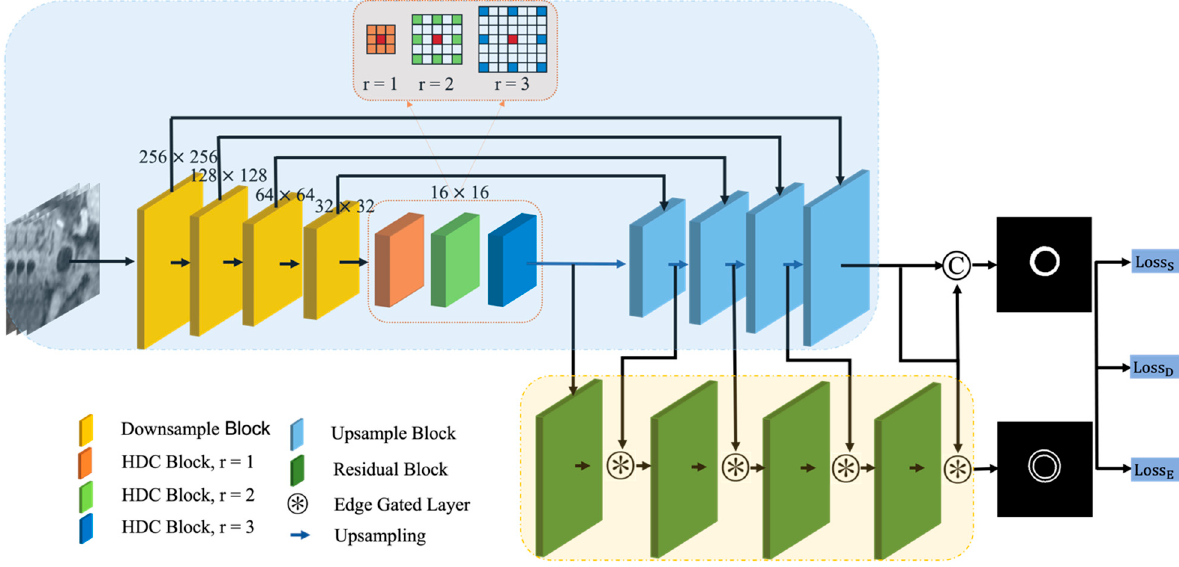
Figure 1. The network architecture of EVSegNet.